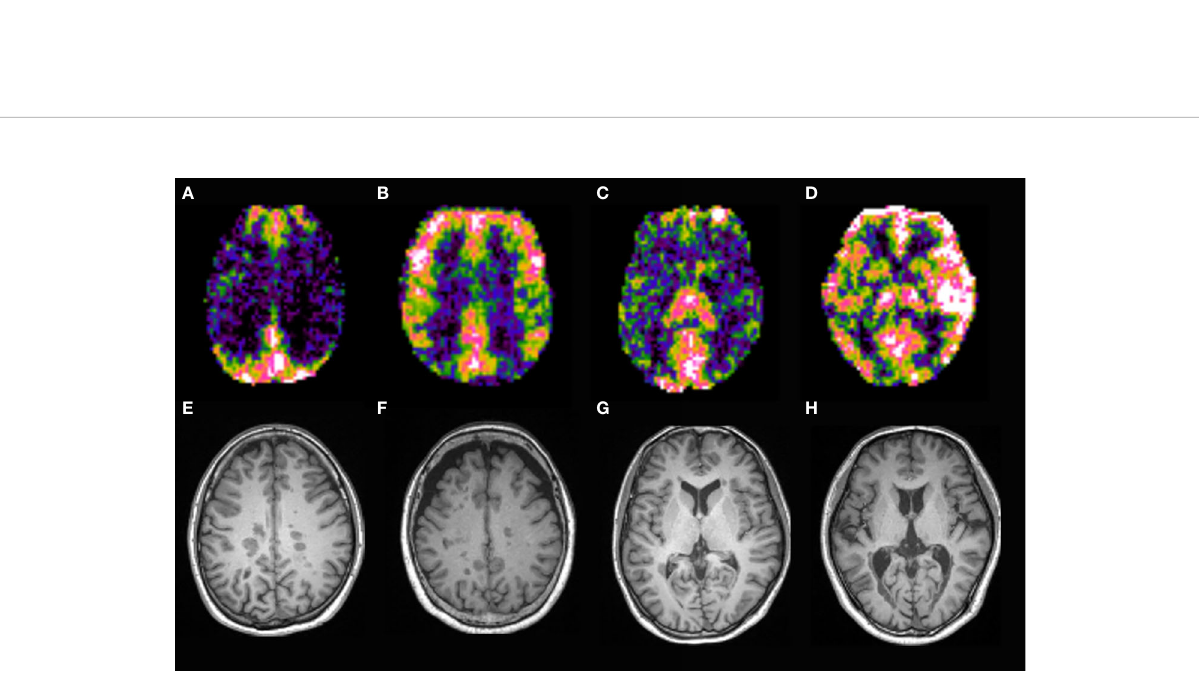
FIGURE 5 CBF map of MS patients. Patients with strongly increased CBF in the parietal lobes (B, F) had higher EDSS and sNfL than those with mildly increased CBF (A, E) . Patients with strongly increased CBF in the temporal lobes and basal ganglia (D, H) had higher EDSS and sNfL than those with mildly increased CBF (C, G)